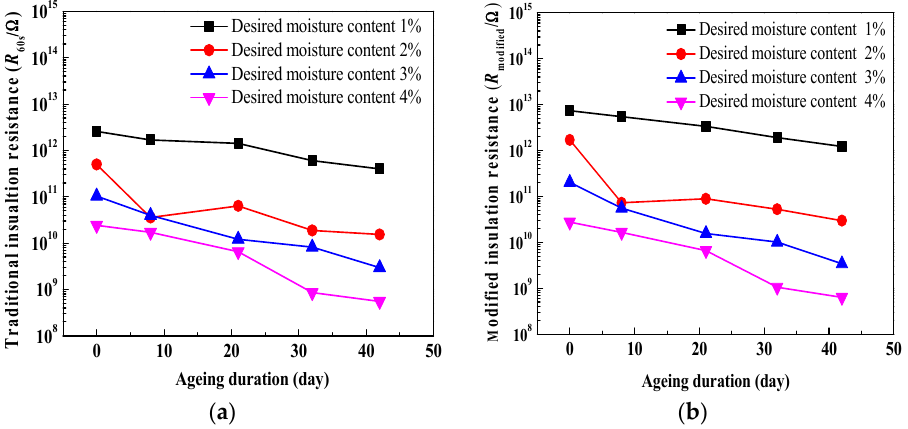
Figure 8. Comparisons of relationships between insulation resistances and ageing duration. ( a ) Traditional insulation resistance; ( b ) modified insulation resistance.